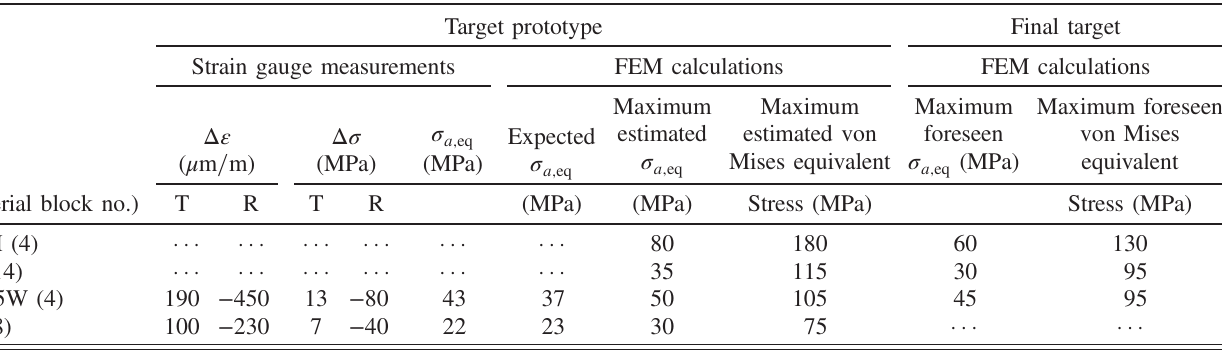
TABLE VII. The table presents the maximum average strain variation per pulse ( Δ ε ) in the transversal (T) and radial (R) directions measured during the BDF target prototype beam tests in the two cladding materials (Ta and Ta2.5W). The values were measured in blocks 4 (Ta2.5W) and 8 (Ta) under a high intensity beam ( 3 . 75 × 10 12 ppp) after steady-state regime was reached. The radial and transversal stress variation ( Δ σ ), and equivalent stress amplitude ( σ a; ) calculated in the measuring points is also displayed, as well as a eq comparison with the expected stress amplitude calculated by means of FEM simulations. The table also shows the maximum stress amplitude and the maximum von Mises equivalent stress reached in the target prototype materials during the beam tests under high intensity operation, estimated through thermomechanical simulations, and for comparison the equivalent stress amplitude and von Mises equivalent stress foreseen during the final BDF target operation are also presented [5].